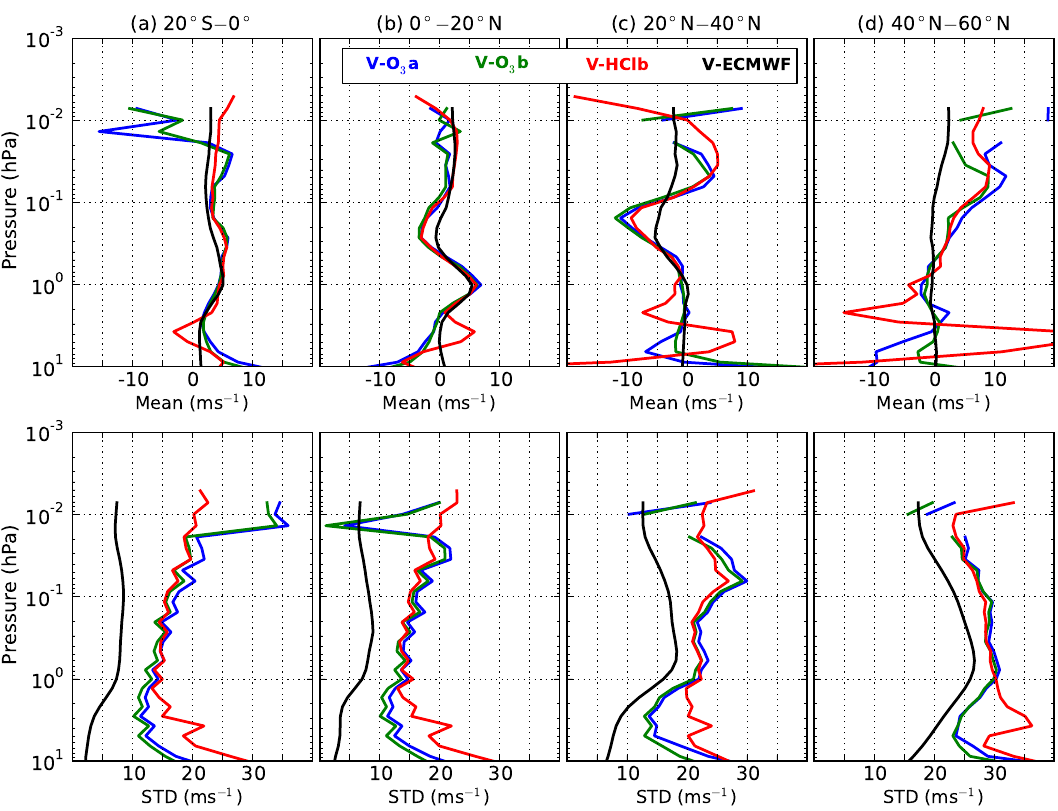
Fig. 6. Upper panels: zonally averaged near meridional wind profiles retrieved from simultaneous measurements of the spectral lines: O 3 - band A (blue line), O 3 -band B (red line) and HCl-band B (green line). Lower panels: same as the upper panels but showing the standard deviation of the retrieved profiles. The results for the paired ECMWF winds component along the line-of-sights are also shown (black line). Data with a line-of-sight orientation between ± 10 ◦ from the meridional direction are